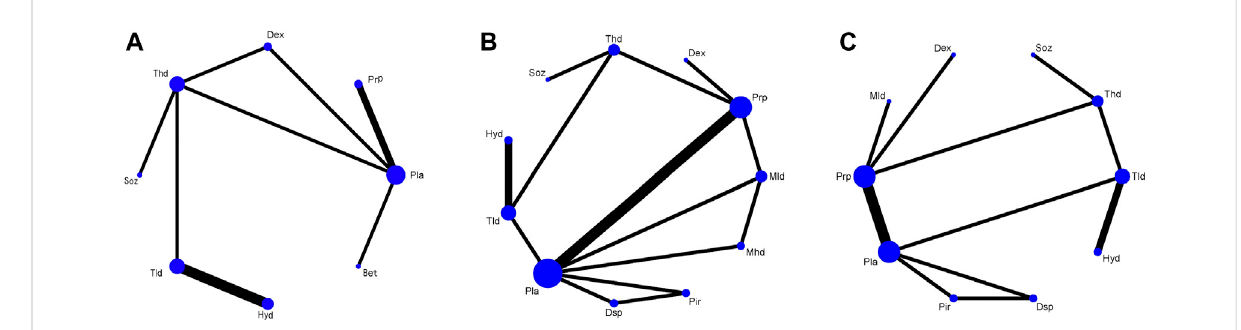
FIGURE 3 Network plots of the VAS (A) , SSS (B), and FSS (C) .